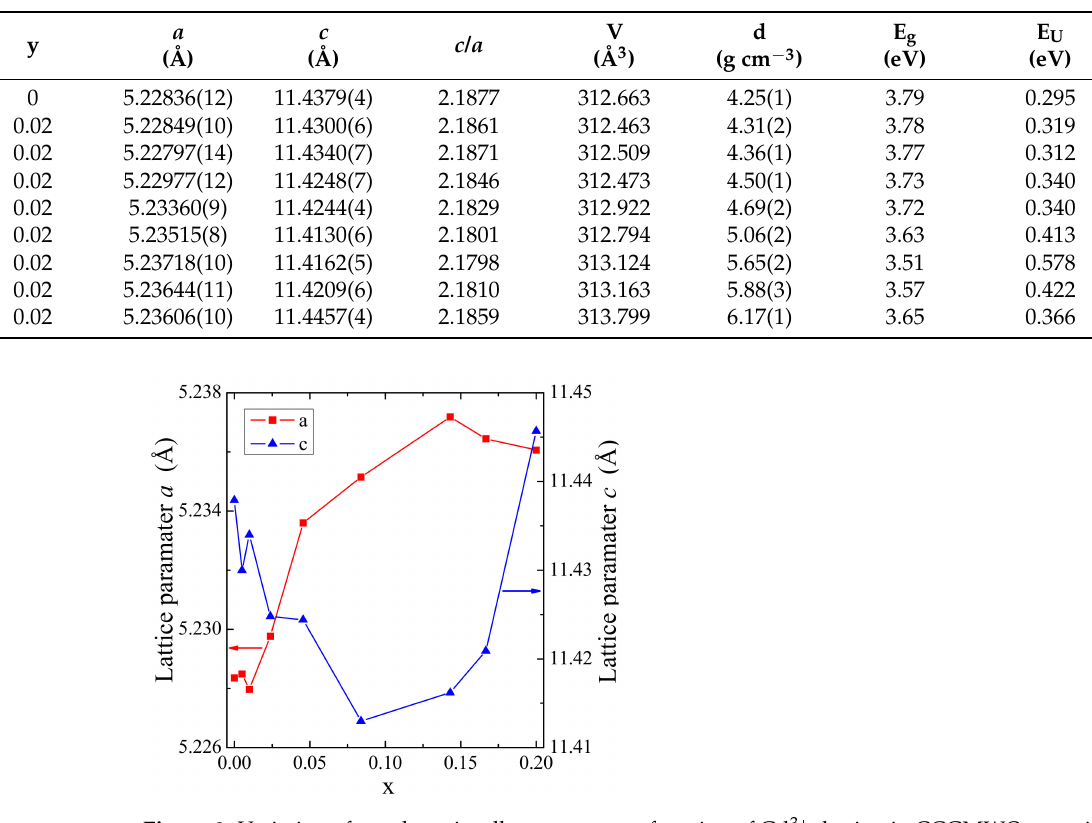
Figure 2. Variation of a and c unit cell constants as a function of Gd 3+ doping in CCGMWO materials.